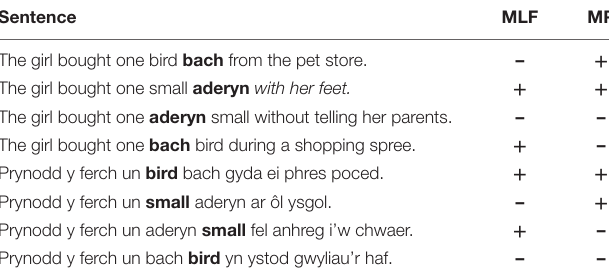
TABLE 2 | Experimental design and stimulus